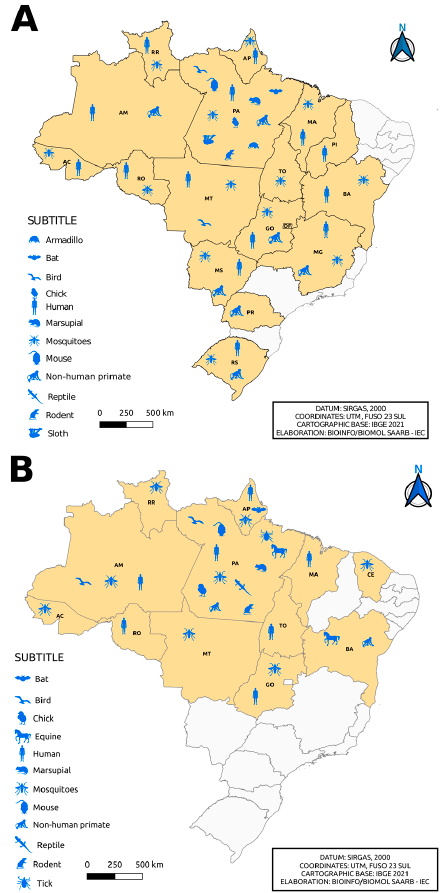
Figure 5. Distribution of the incidence of Flavivirus ( A ) and Alphavirus ( B ) reservoirs by federative unit of Brazil. The isolation of fl avivirus and alphavirus occurred in other locations in Brazilian